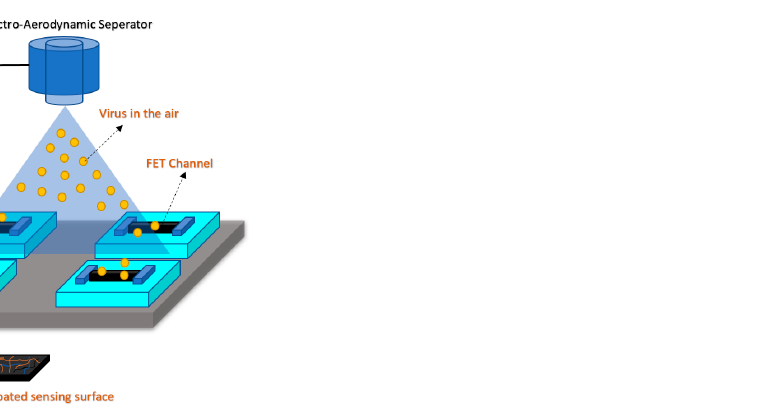
17 of 50 Figure 16. The schematic of silicon nanowire (SiNW) integrated with PDMS microfluidic channel which was designed to direct the flow of sample of interest toward the solution. An Ag/AgCl elec- trode is integrated by placing its tip in the inlet of the microfluidic channel. The ultrasensitive detection of H5N2 AIV was demonstrated using a reusable SiNW FET, which was made possible by the reversible surface functionalization on the SiNW via a disulphide linker. They reported a successful reversible surface functionalization, which was then examined by electrical and microfluorescence methods. By this innova- tion, they could reach detections of very dilute H5N2 AIV at 10 − 12 –10 − 17 M [90]. As a back gated structure for SiNW sensors, based on a CMOS fabrication process, a